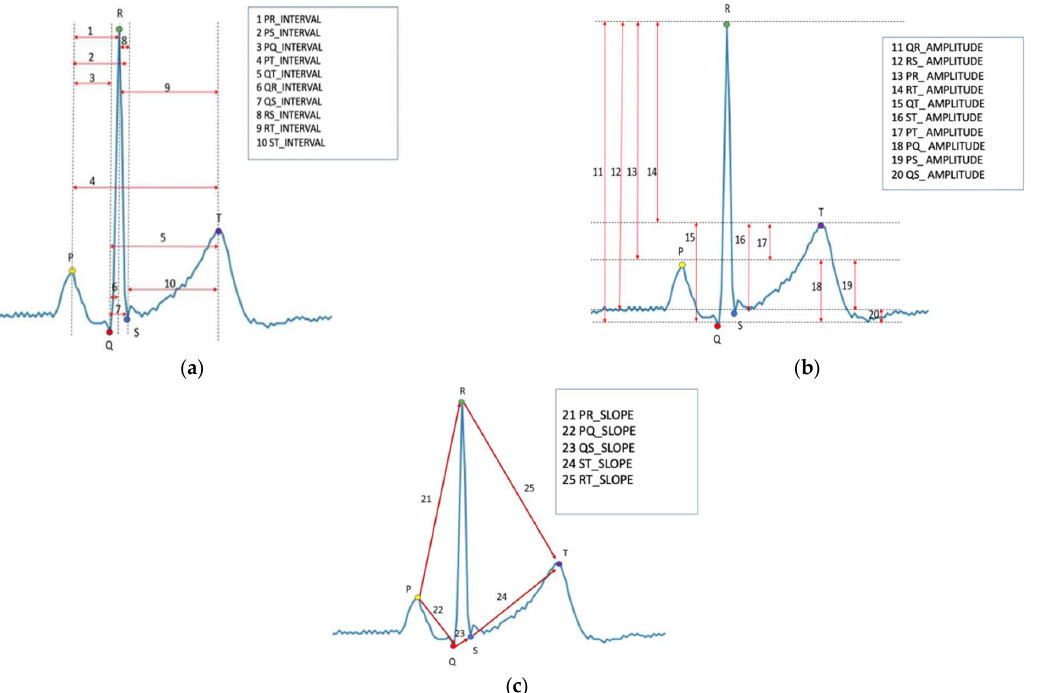
Figure 1. The extracted features from one heartbeat ECG cycle. ( a ) Features of 10 different intervals, ( b ) features of 10 different amplitude, ( c ) features of 5 different slope gradients.